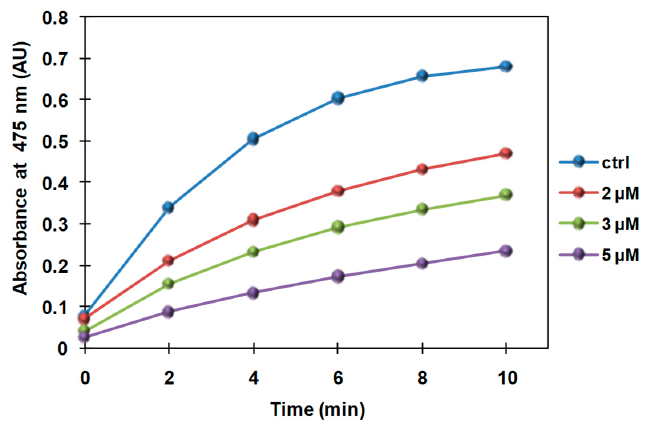
Figure 2. Time course of the absorbance change at 475 nm in the oxidation mixture of L ‐ DOPA (1 mM) with mushroom tyrosinase in the absence (control (ctrl)) or presence of different concentrations of LC. Reported are the mean values of at least three experiments (standard deviation (SD) < 5%). AU: Arbitrary units.